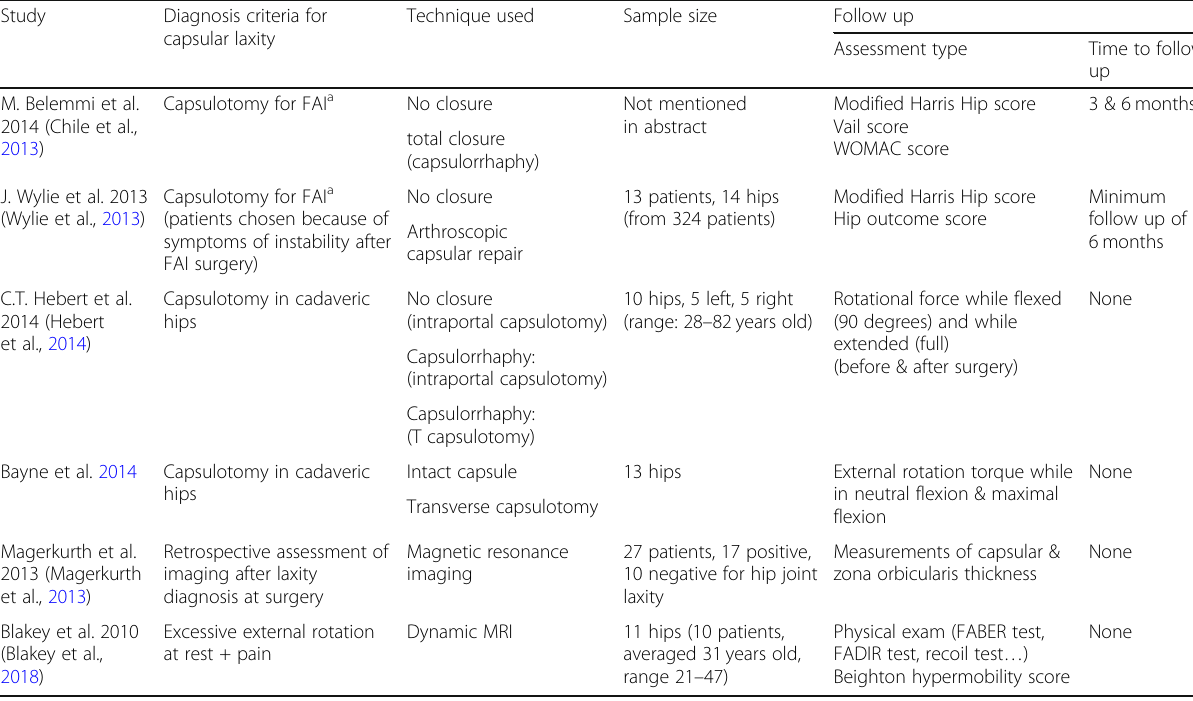
Table 1 Studies on ranges of motion associated with hip capsular laxity from arthroscopy and imaging technique for diagnosis